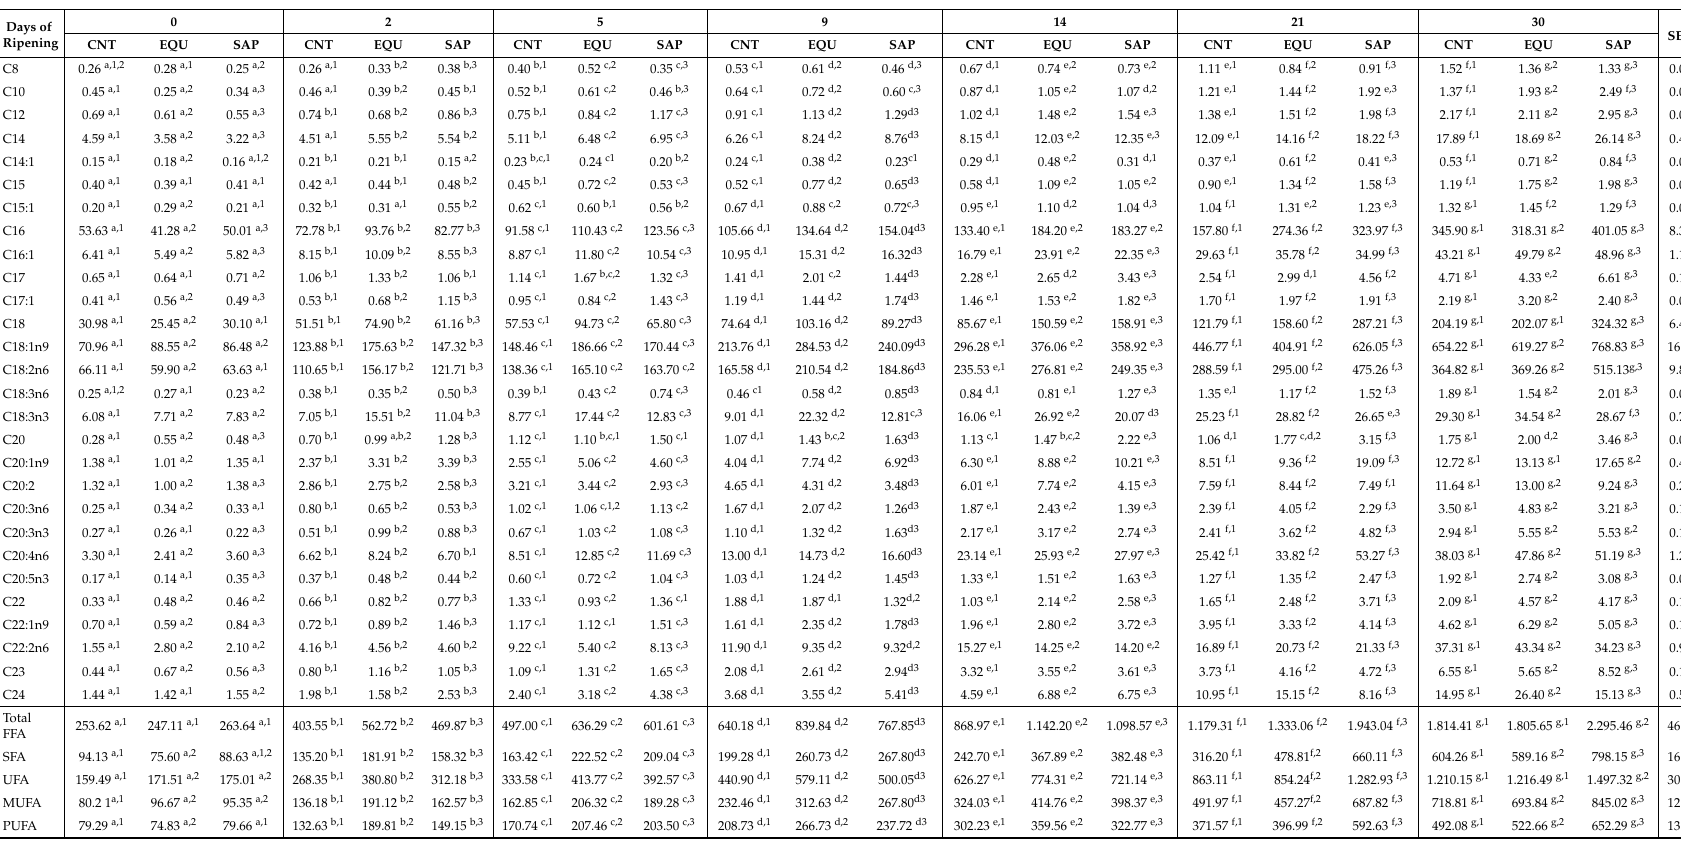
Table 8. Evolution of the free fatty acids (mg FFA / 100g of fat) along the manufacturing process of Galician chorizo made without and with starter cultures (mean values of three batches in each sausage